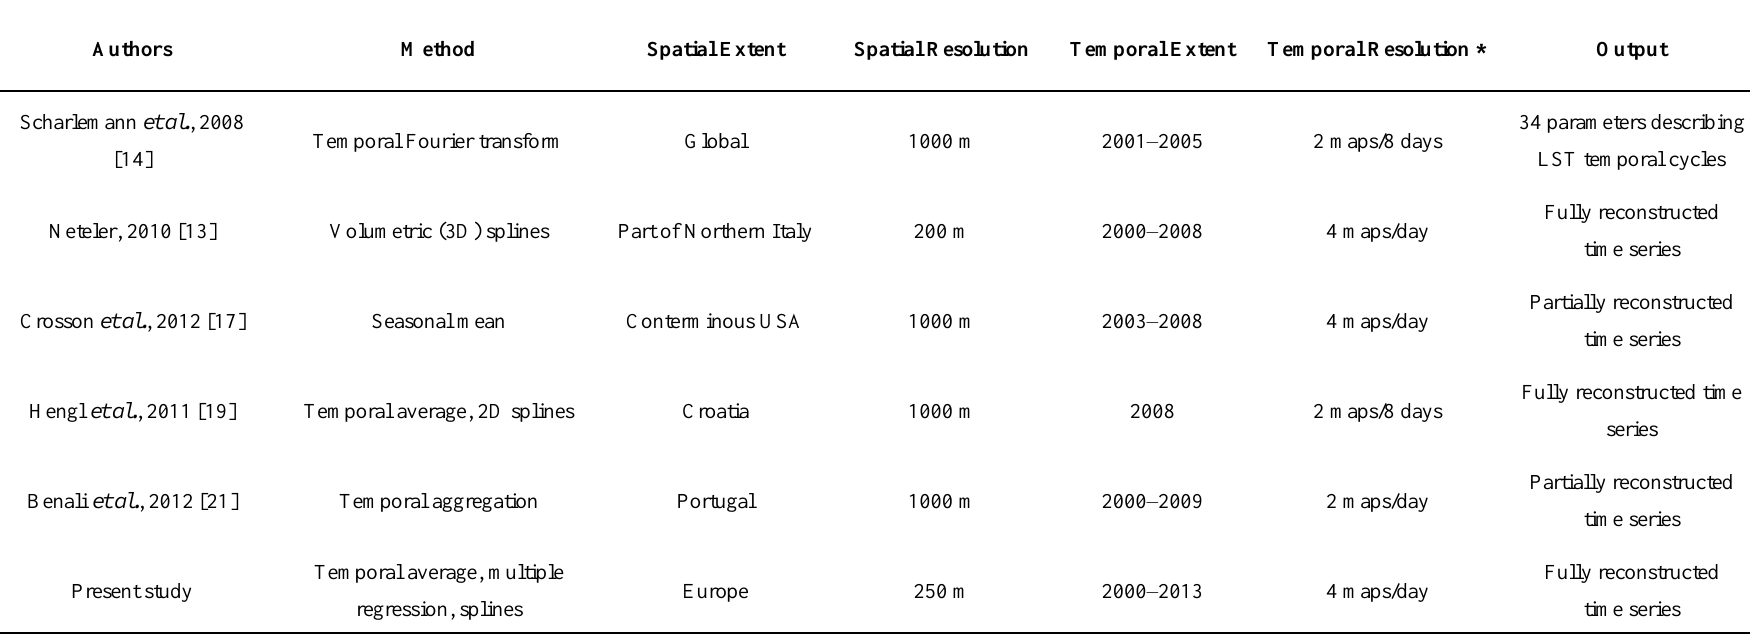
Table 1. Non-exhaustive list of previous publications on MODIS land surface temperature (LST) reconstruction. * MODIS LST products are available as daily data (two overpasses per satellite), as well as eight-day and monthly aggregates. Each product includes daytime and nighttime LST. The highest temporal resolution is thus achieved by using both the Terra and Aqua daily products (four maps per